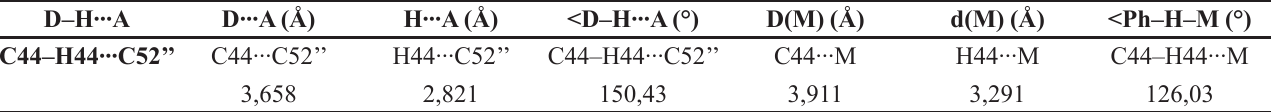
TABLE III - Geometric parameters for the non-classical aromatic hydrogen bonds (C-H ∙∙∙ Ph) of the 1-D arrangement of the complex